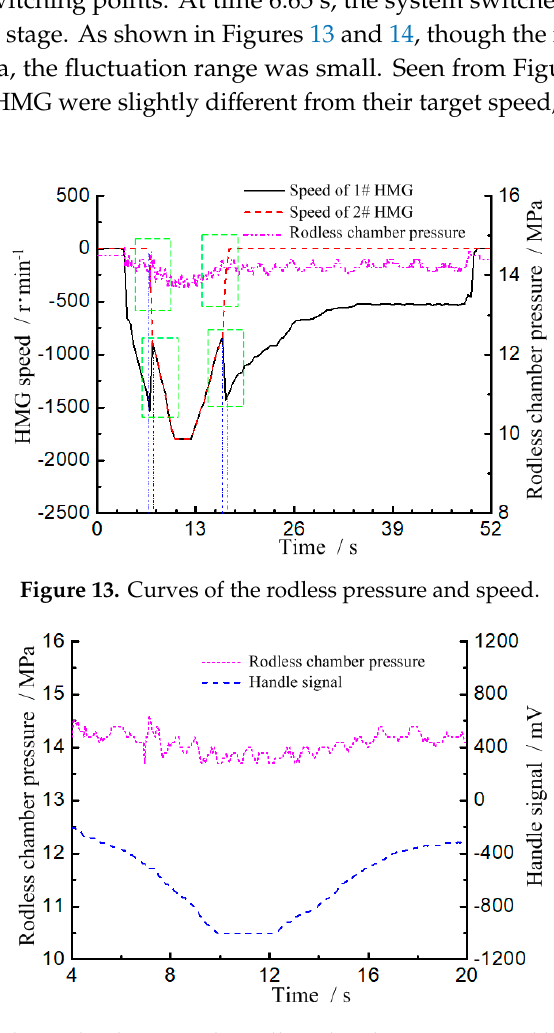
Figure 14. Relationship between the rodless chamber pressure and handle signal.